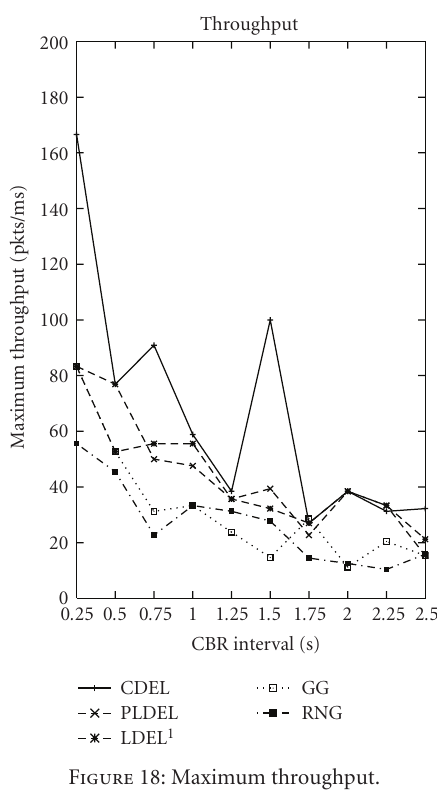
Figure 18: Maximum throughput.